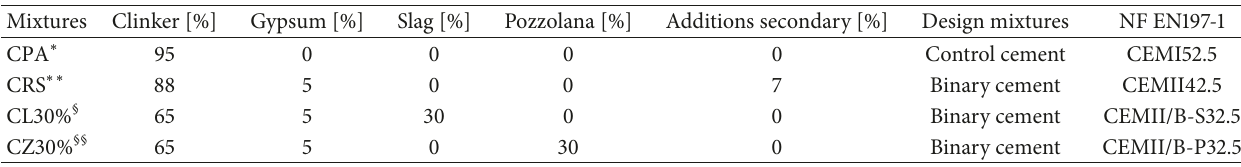
Table 1: Composition of the different mixtures